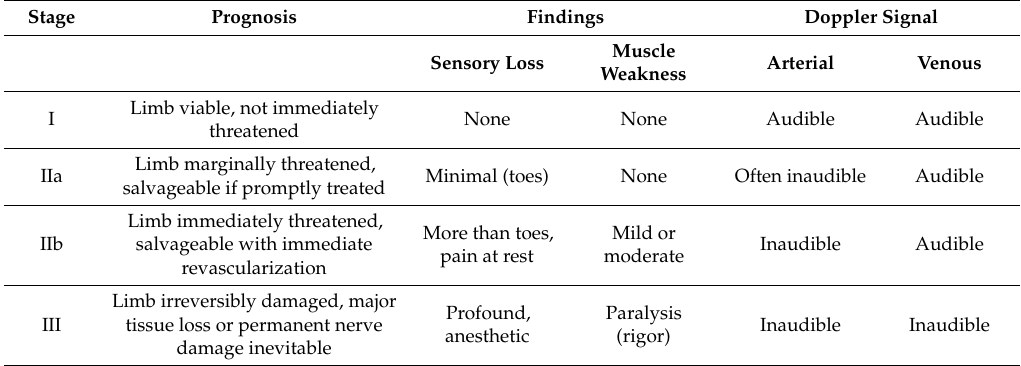
Table 1. Stages of acute limb ischemia (ALI) according to the Rutherford classification